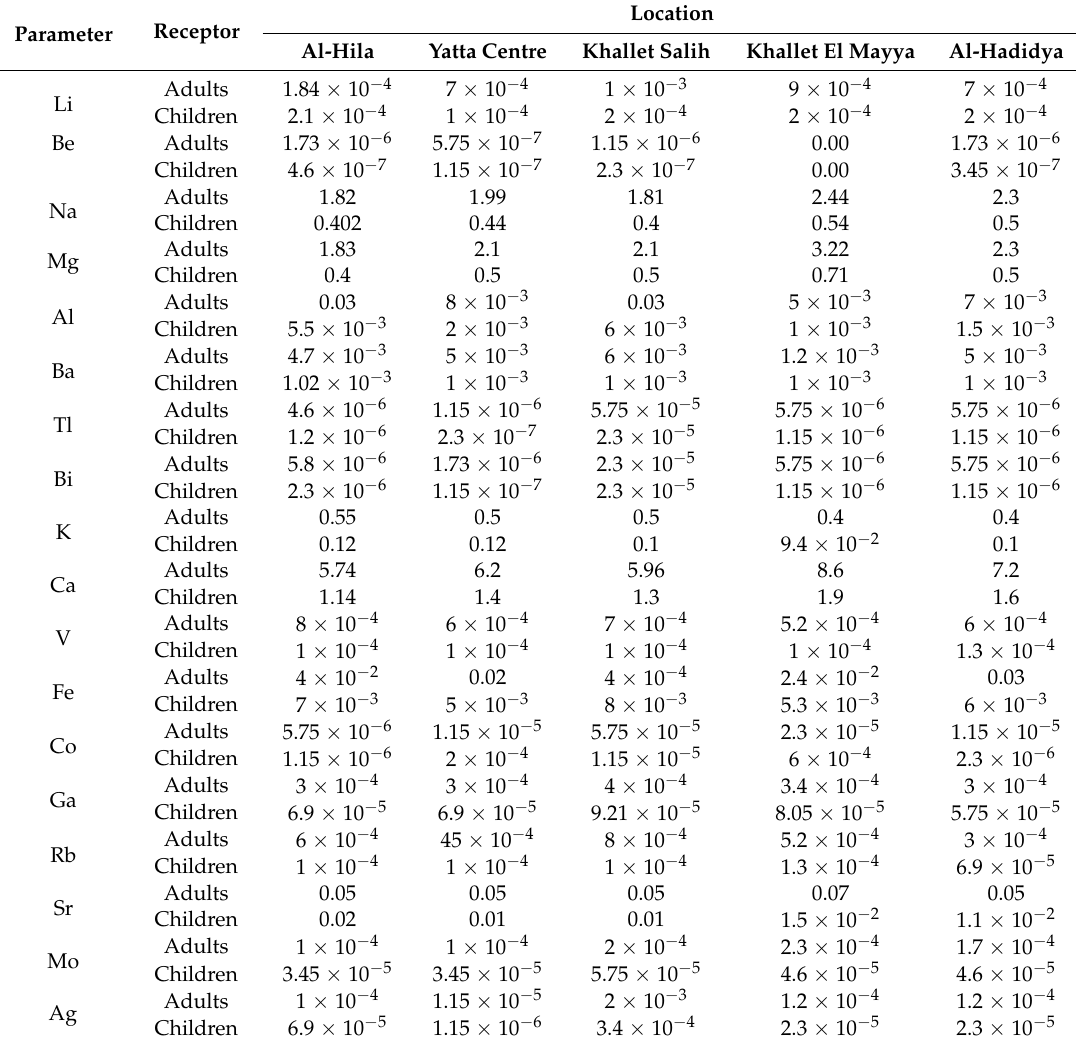
Table 2. CR ing projection of heavy metals through rainwater harvesting cisterns (n = 74).